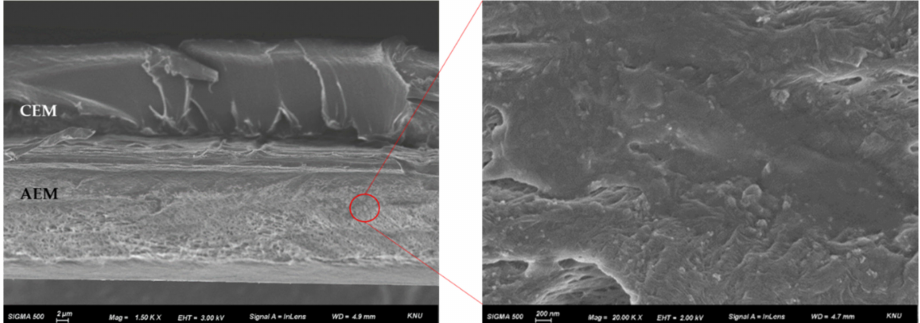
Figure 8. Cross-sectional FE-SEM image ( left , 1.50k × ) of fabricated BPM and higher magnification image ( right , 20.00k × ) of anion-exchange